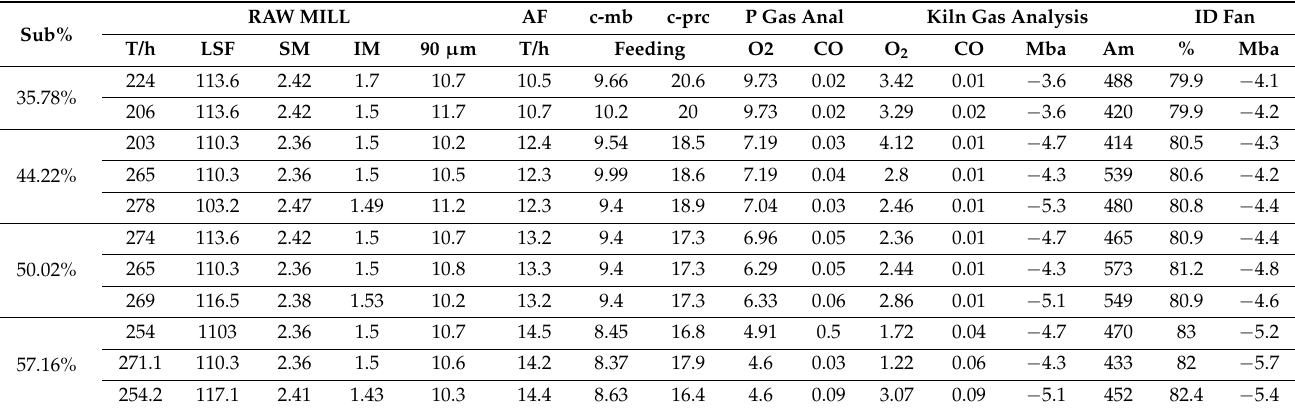
Table 8. Pyro system technical performance record at various AF: coal substitution